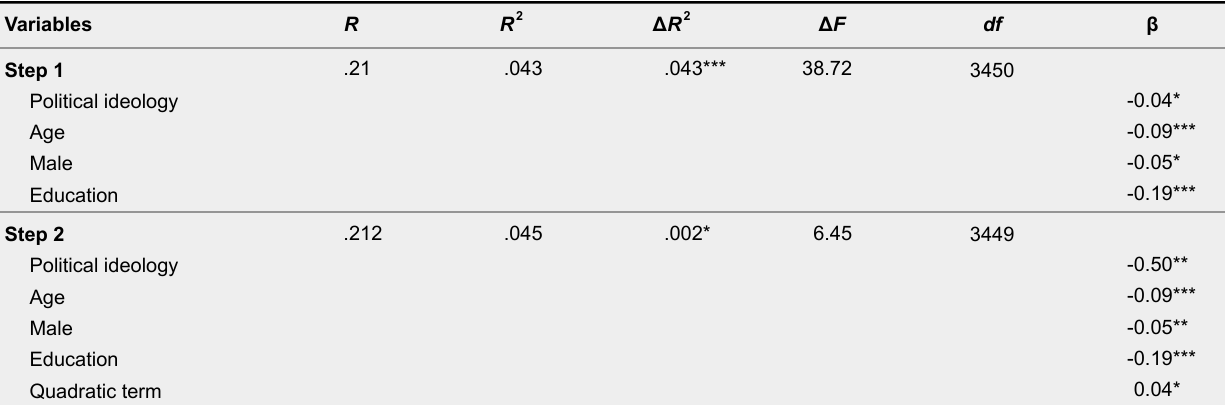
Determinants Explaining Belief in Conspiracy Theories (Index)